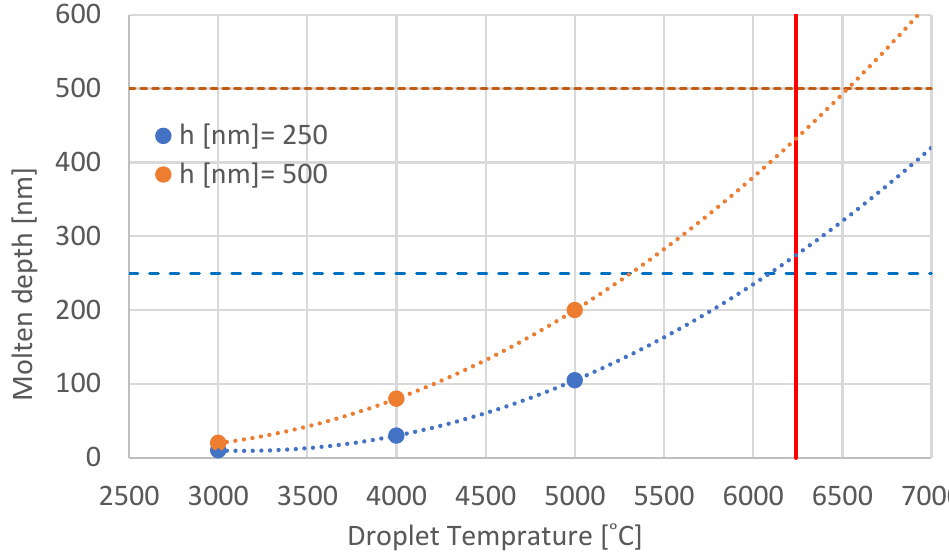
Figure 4. Melting depth from 2D COMSOL thermal simulation of Molten depth vs. droplet temperature for two initial droplet thicknesses: 250 nm and 500 nm. The red vertical line depicts the droplet temperature as obtained from Equation (7). Comparison with COMSOL simulation is quite good. The dotted lines are polynomial fitting lines with extrapolation to a higher tempera- ture.